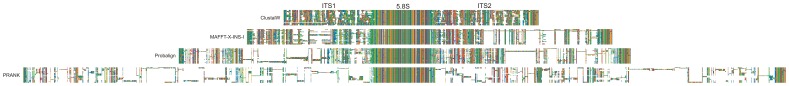
An example of differences in indel placement and alignment overmatching under various alignment algorithms in a family/genus level dataset.Three major features, the internal transcribed spacer 1, the fragment coding for the 5.8S ribosomal RNA and the internal transcribed spacer 2 are discernable, of which the 5.8S fragment is highly conserved, whereas ITS1 and ITS2 are rich both in nucleotide substitutions and length-mutations. Data are from Lutzoni et al [18].